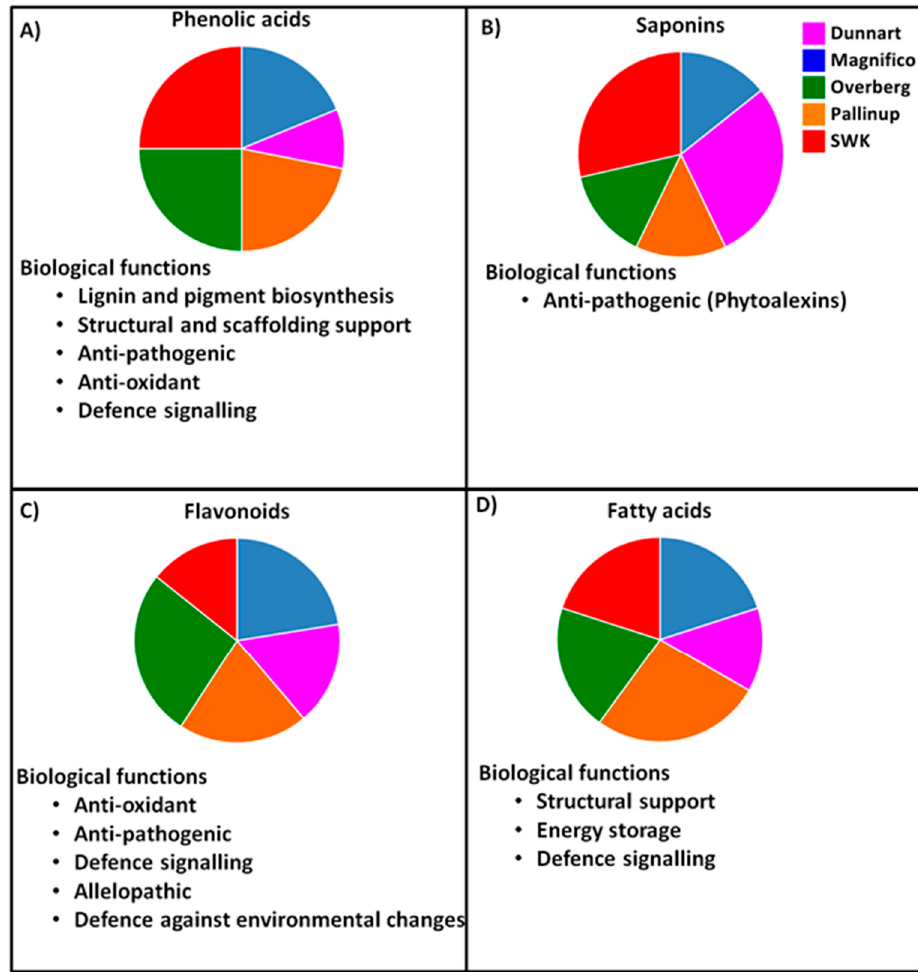
Figure 12. The distribution of the identified metabolite classes across the respective cultivars (Over- berg, Pallinup, Dunnart, Magnifico and SWK001). This figure summarises cultivar-related differences due to underlying metabolic profiles of both leaves and roots. Each pie chart illustrates where a greater number of discriminatory metabolites were identified for each class across the cultivars.